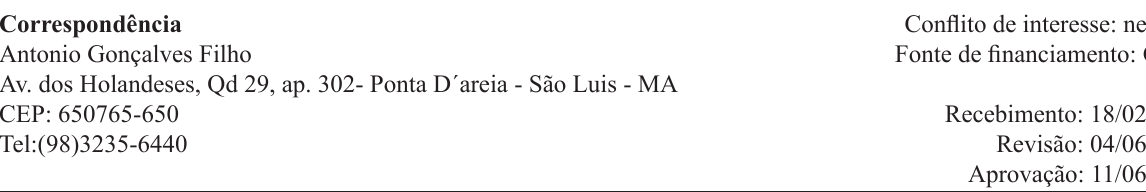
Figuras coloridas disponíveis em